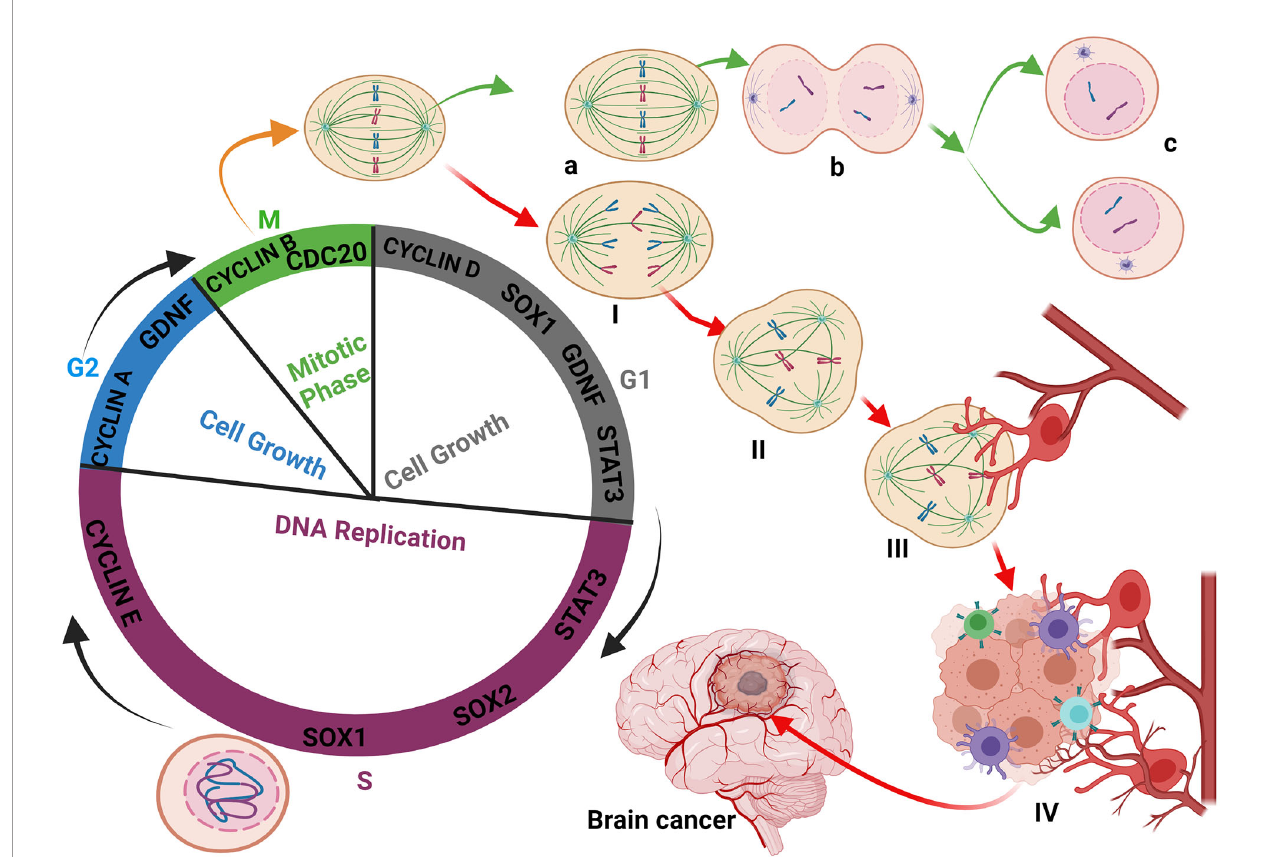
FIGURE 1 | Glioma initiation: Interaction between the abnormal undivided cell and immune cells. During the cell cycle, the defective cell is not allowed to achieve division. Immune cells-like macrophages and T-cells destroyed the defective cell to prevent cancer initiation. Most of the oncogenes expressed during the cell cycle process are mainly Cyclins, GDNF, STAT3, and SOX family members to maintain the checkpoints and respect the timeline of cell division and integrity (A – C) . The fact that certain defective cells are blocked and cannot achieve their division stagnates and is continuously exposed and affected by the cell cycle oncogenes (I, II). The exposure of certain immune cells to GDNF reprogrammed and modi fi ed their polarity, leading to their activation and massive release of cytokines (III). The reprogramming of macrophages by the bonding of TGF- b family members on their membrane receptor retains the macrophages on their activated form. Sometimes, due to unknown reasons, the defective cell can migrate closer to the blood vessels and bene fi t from reprogrammed immune cells, which stimulate their multiplication (IV) through cytokine synthesis, activation, and modi fi cation of the cell ’ s metabolism leading to epigenetics modi fi cation and glioma